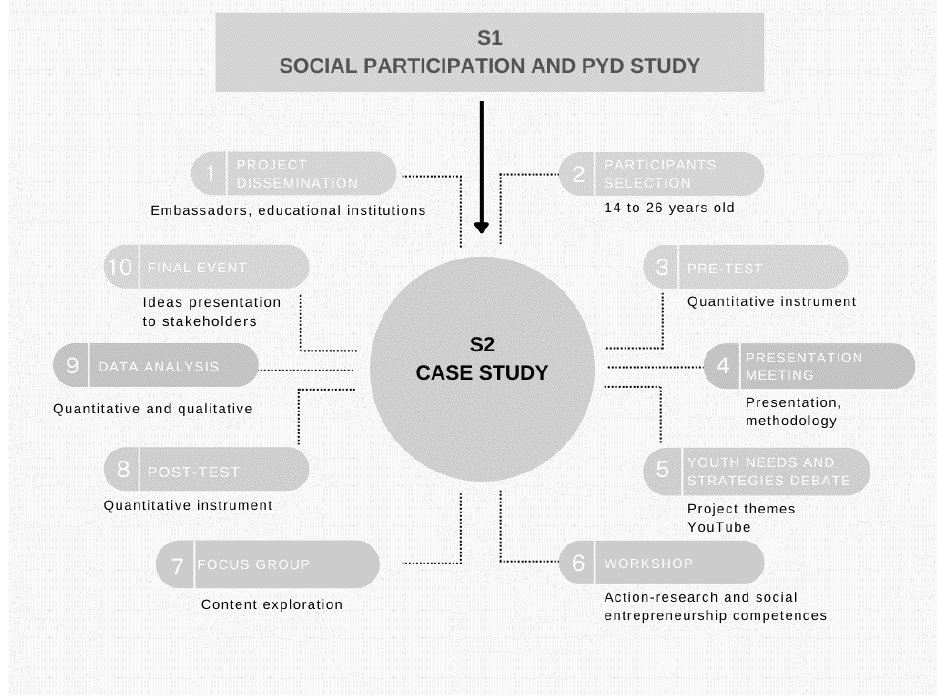
Figure 1. Work Figure 1. Work Methodology.